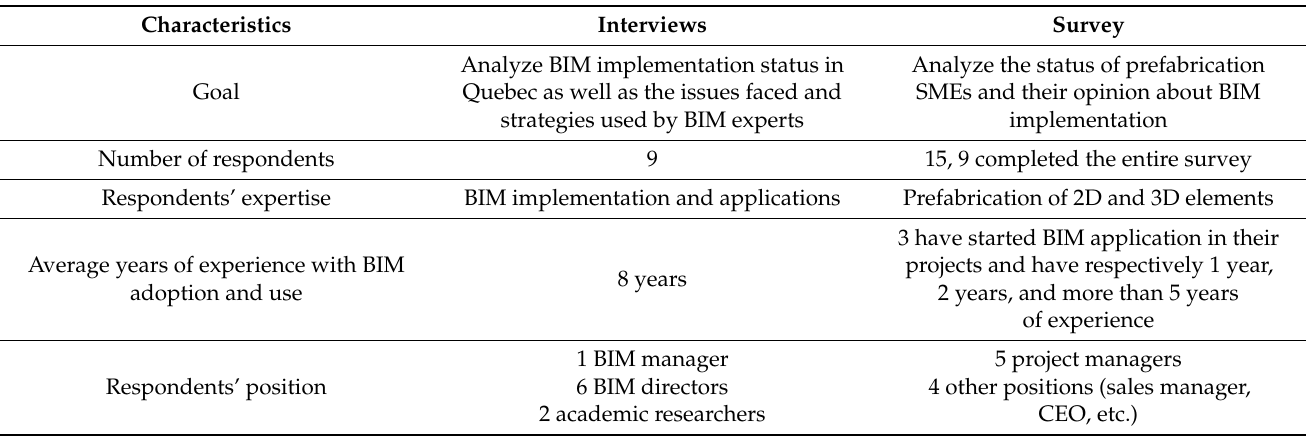
Table 1. Summary of the interviews and the survey conducted for the